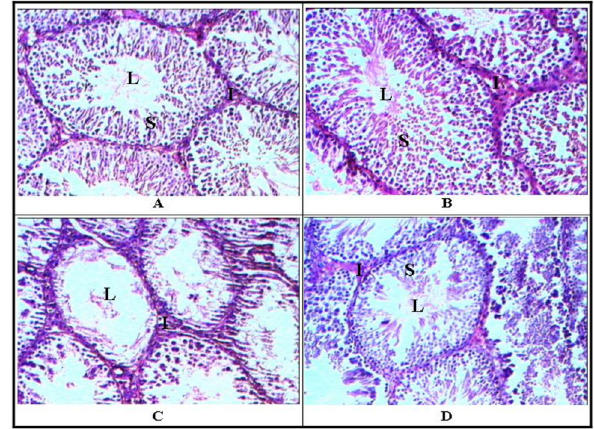
Figure 1 - The testicular histology of the control (A), Eurycoma longifolia Jack-treated (B), estradiol-treated (C) and combined EL and estradiol-treated (D) rats. Letters in the micrographs indicate the lumen of the seminiferous tubule (L), spermatogenic cells (S) and interstitial tissue (I) (200x magni- fication)